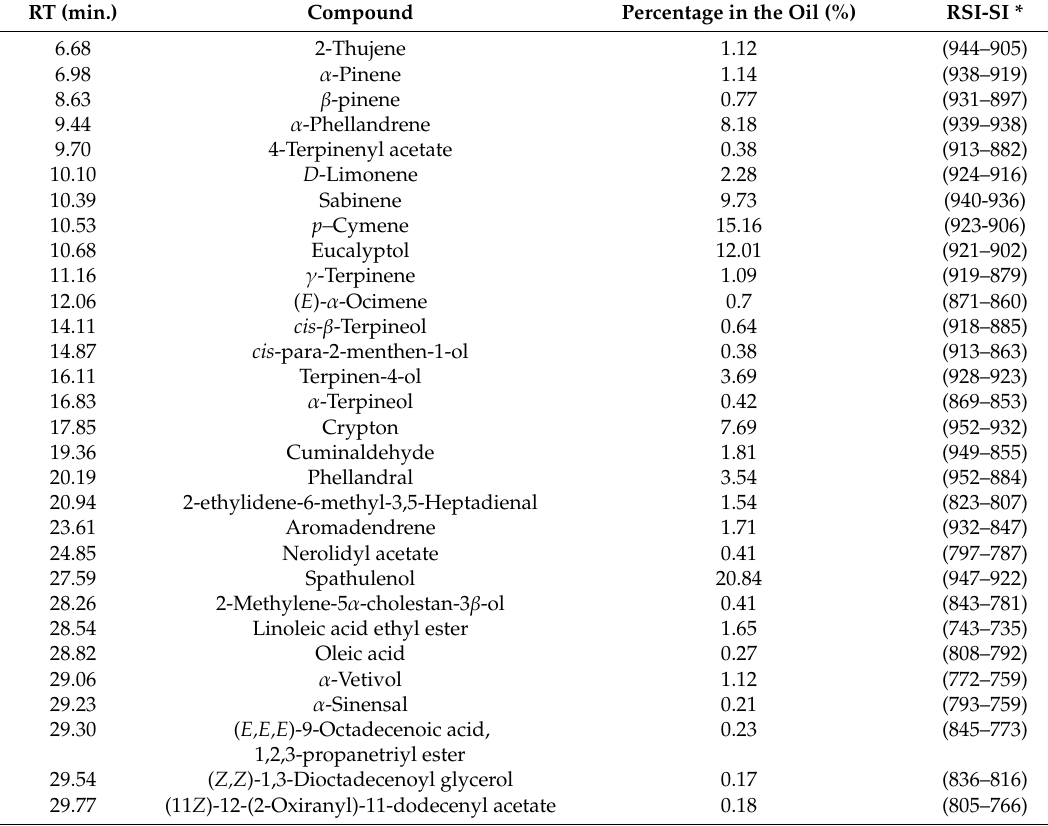
Table 2. Phytochemical composition of E. camaldulensis essential oil by GC / MS. RT